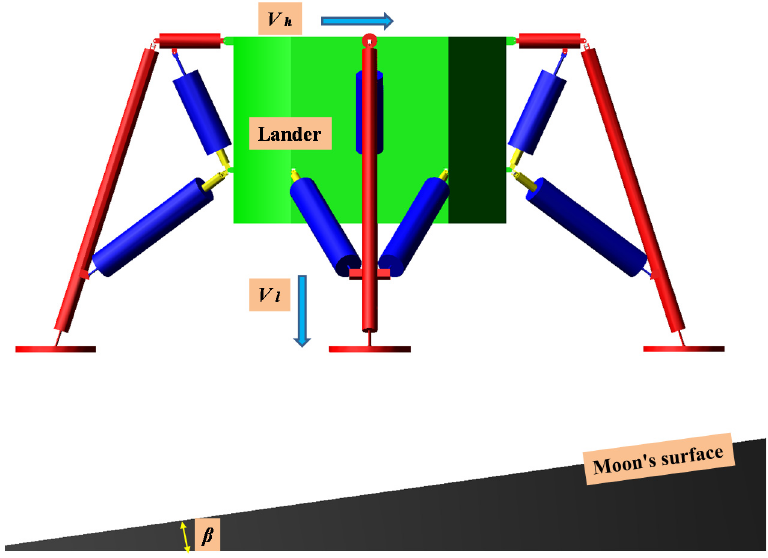
Figure 16. Landing conditions.